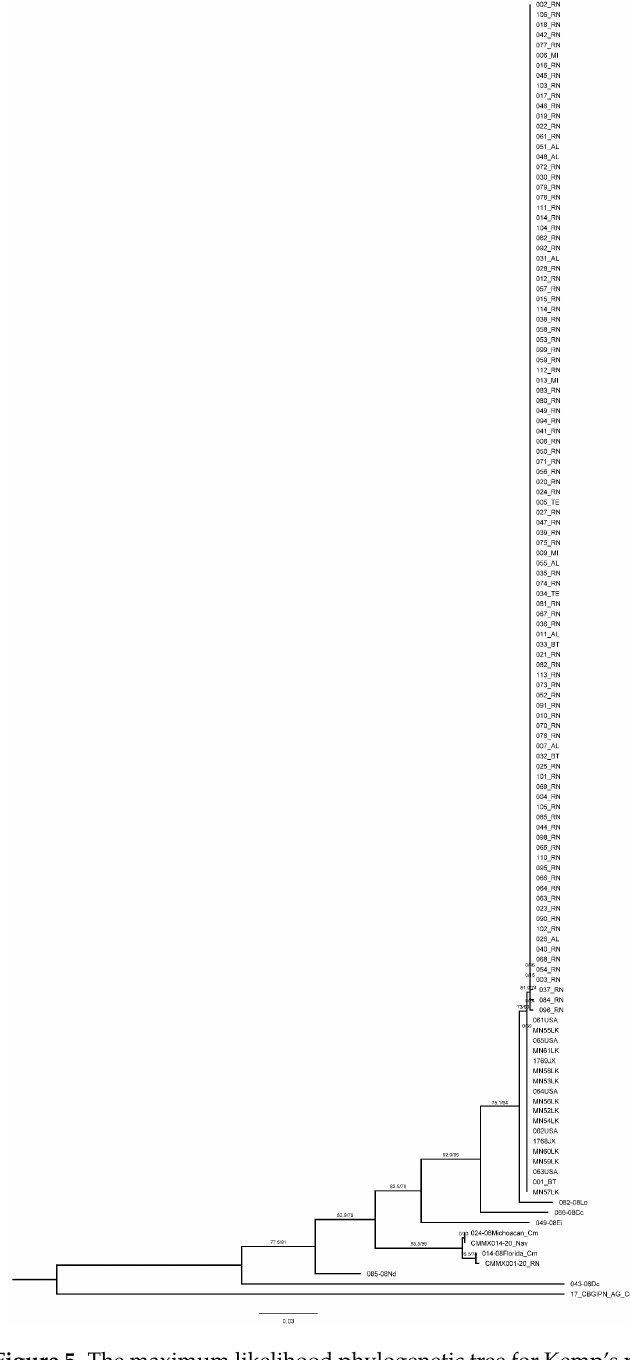
Figure 5. The maximum likelihood phylogenetic tree for Kemp’s ridley representing the phylogenetic relationships for the 624 bp COI sequence with the marine turtle outer